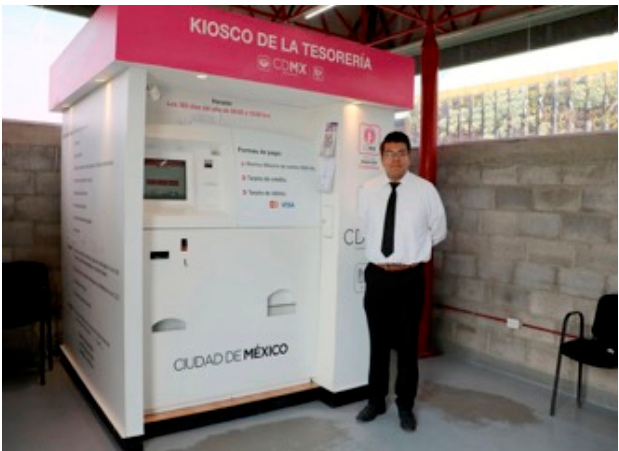
Figure 32. Interface of Mexico City Government Treasury kiosk. Government staff member needs to help citizens.